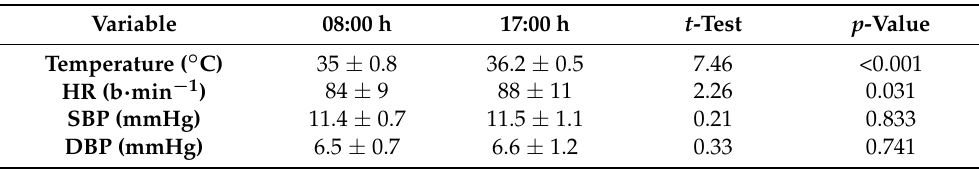
Table 3. Intra-oral temperature, heart rate (HR), systolic blood pressure (SBP) and diastolic blood pressure (DBP) recorded at the two